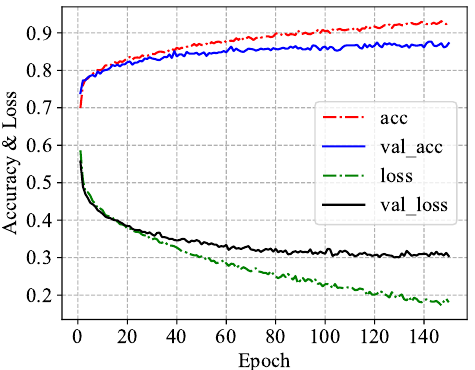
Figure 15. Loss function and accuracy evolution of the training and validation sets during the training